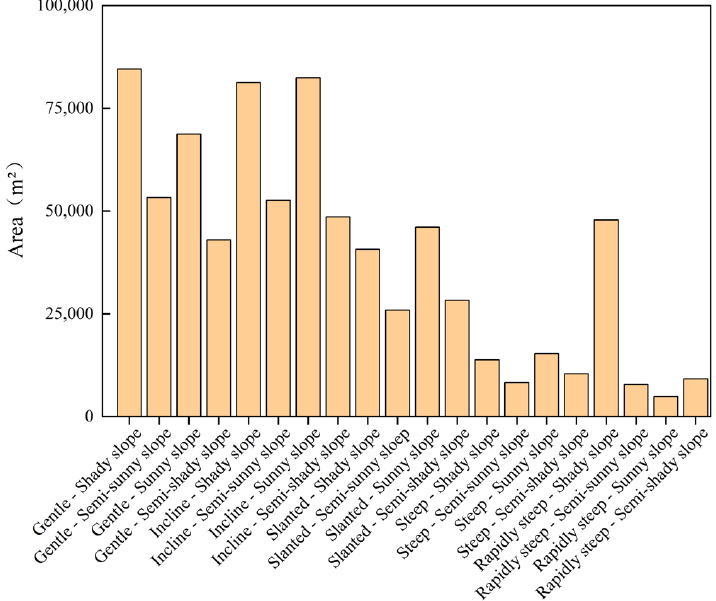
Figure 15. Area of 20 combinations.